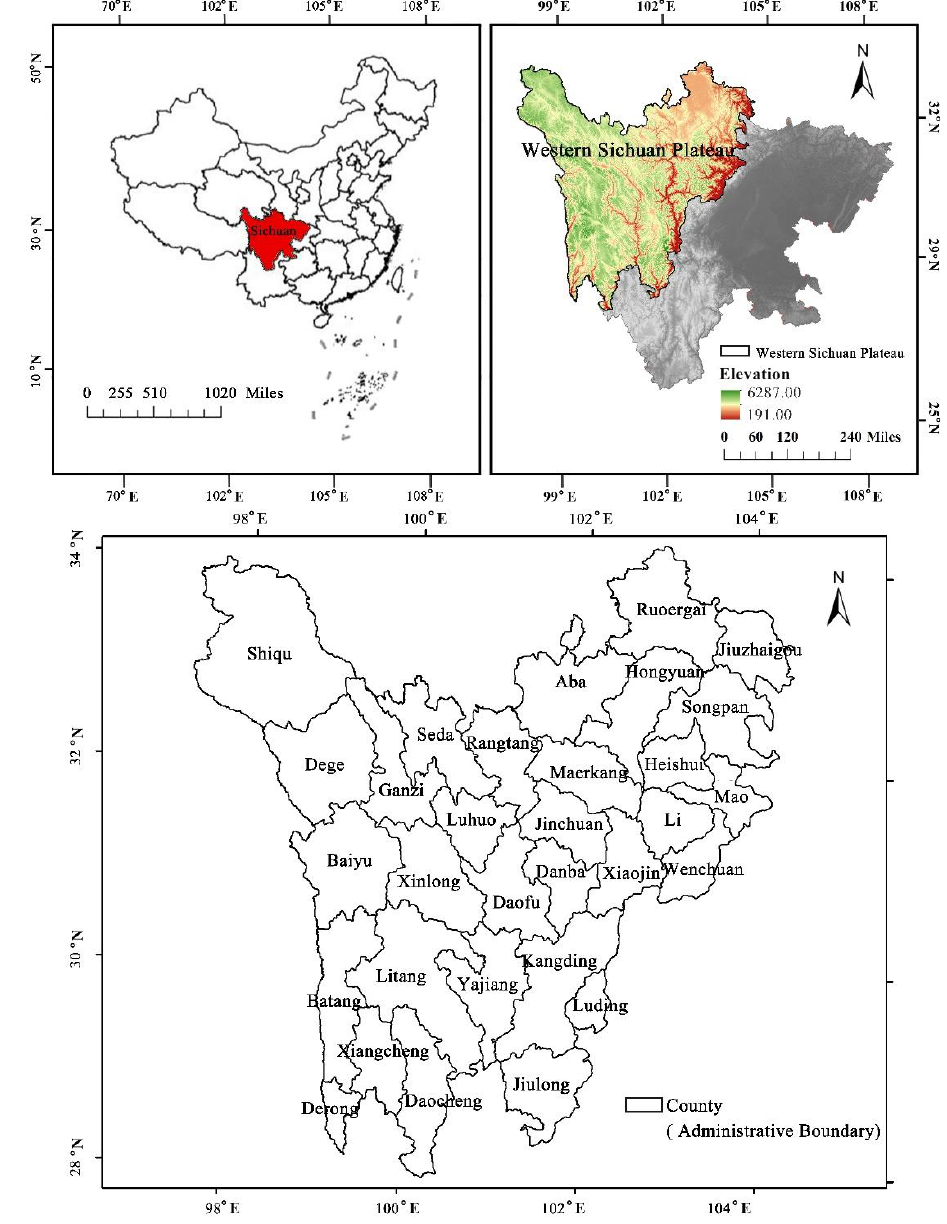
Figure 1. Location and overview of the western Sichuan Plateau.